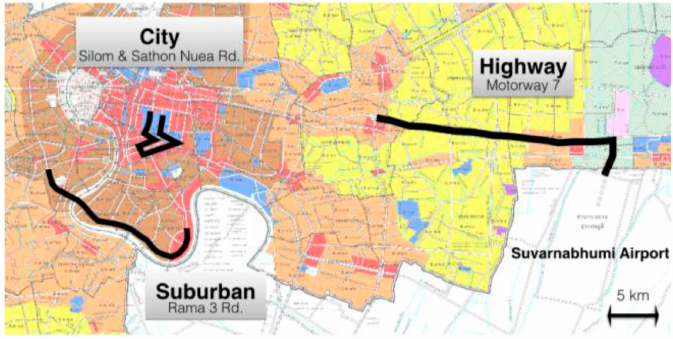
Figure 1. Analytical experimental set-up and equipment. 2.2. Real-World Experiment This dataset is implemented in the fuel consumption model construction and the result validation. This second dataset was collected under real-world traffic conditions in Bangkok, Thailand in 2015. The selected routes were Silom-Sathon Nuea, Rama 3, and Motorway 7, which represented Bangkok’s typical city, suburban and highway traffic conditions well, respectively. Figure 2 shows the orientations and locations of the experimental routes. The colors illustrate the